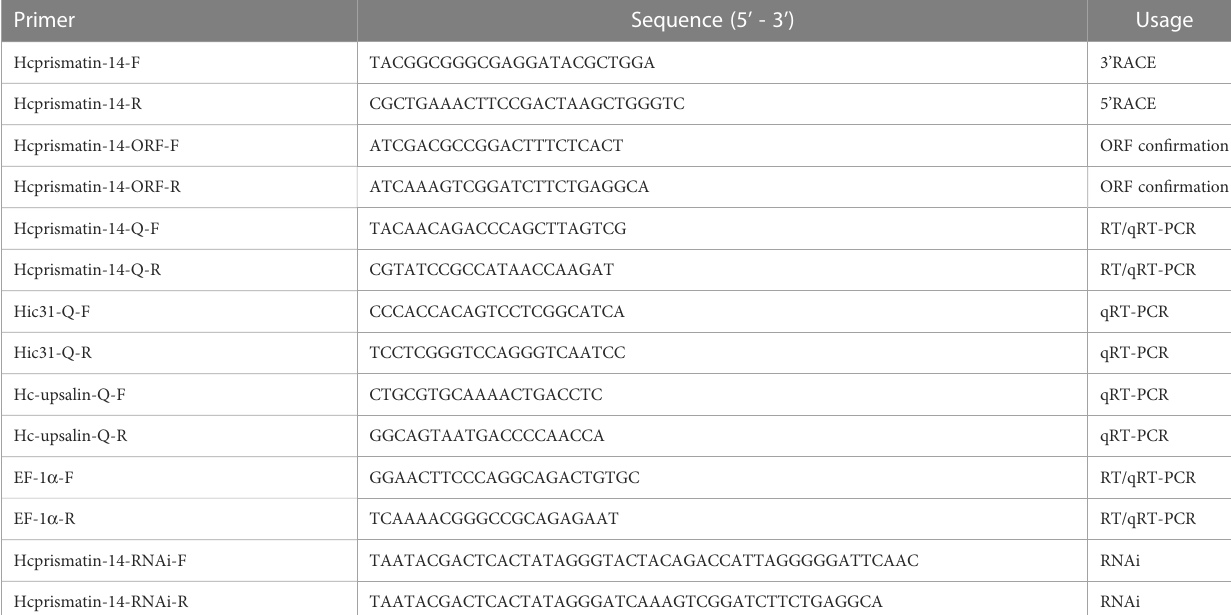
TABLE 1 Primers used in